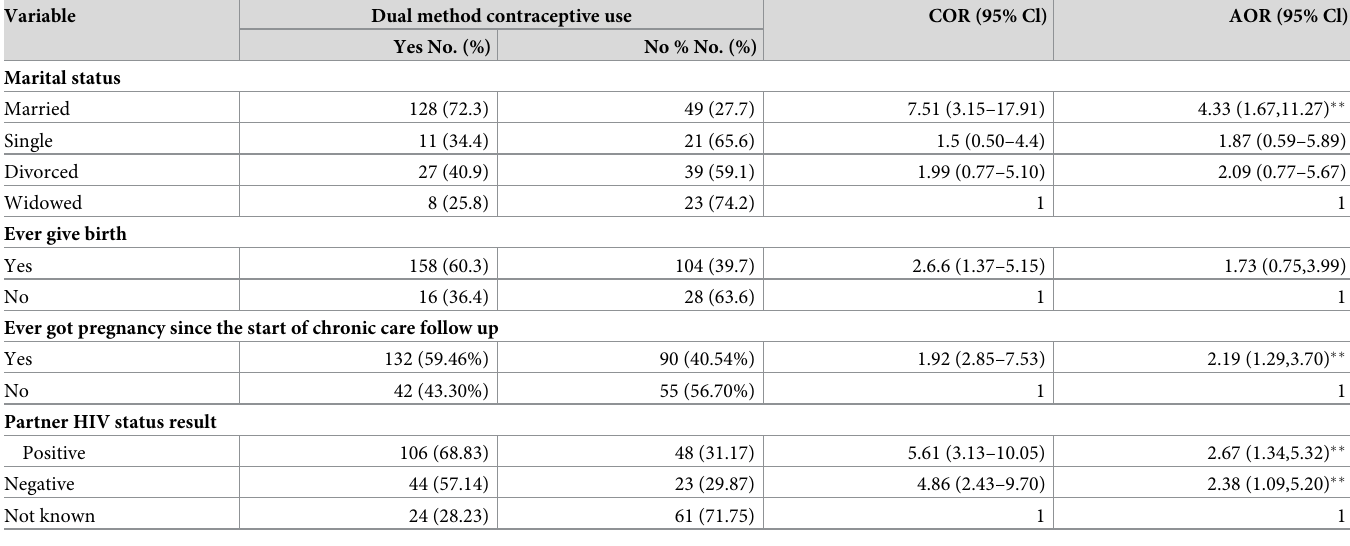
Table 4. Bivariable and multivariable logistic regression analysis of factors associated with dual method contraceptive utilization among HIV positive women on chronic care in Bishoftu Town Health institution, 2020.